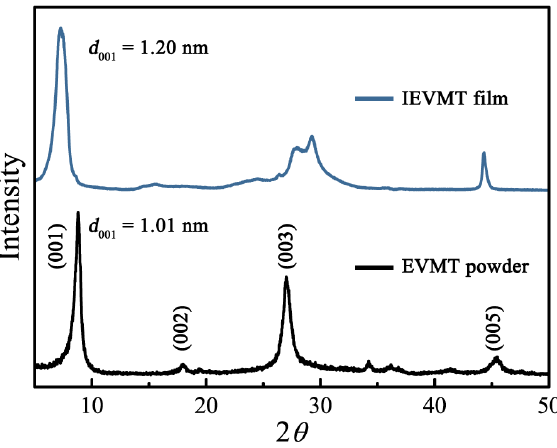
Figure 4. XRD patterns of the EVMT powder and the films after ion exchange.